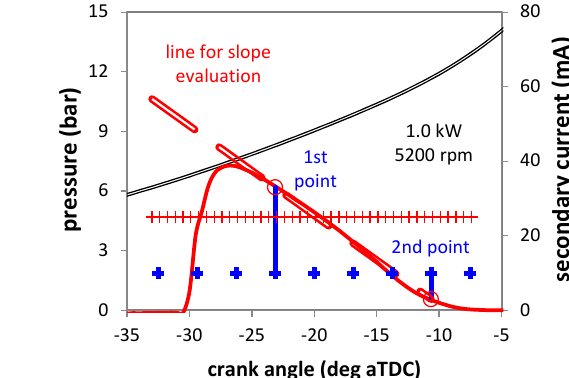
Figure 11. Illustration of sample rate effects on the points read during spark events.